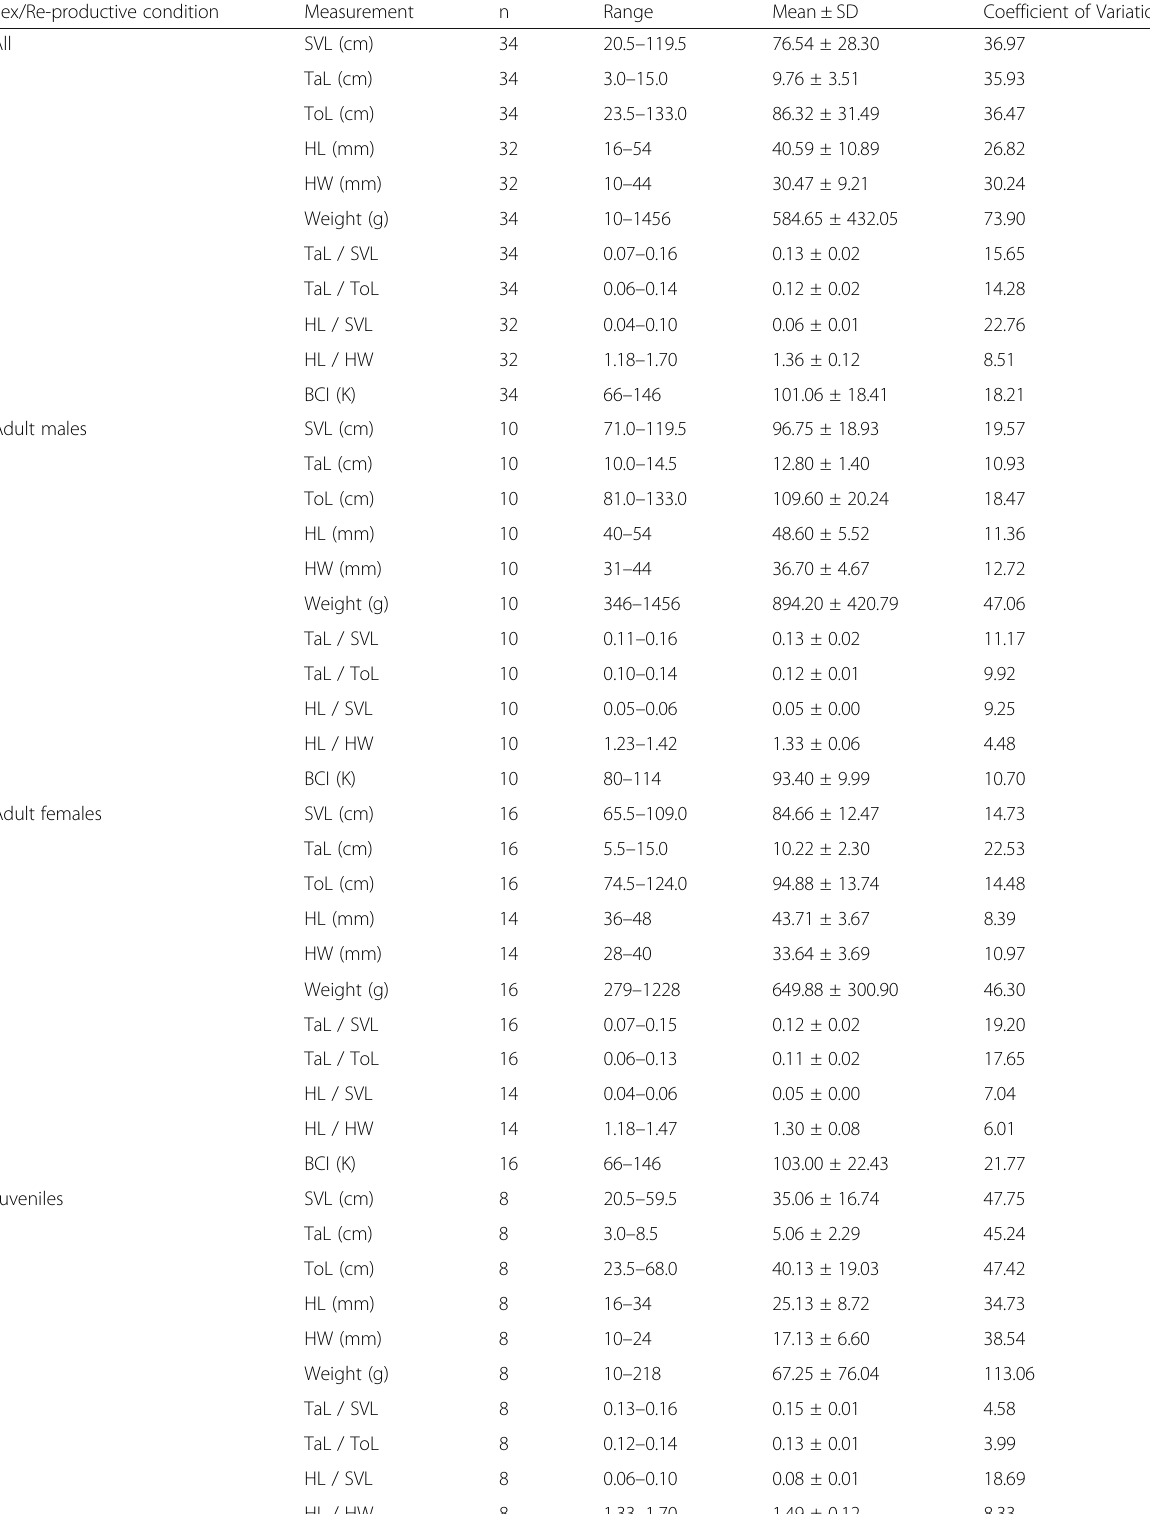
Table 1 Morphometric characteristics of juvenile and adult blunt-nosed vipers from Cyprus (SVL, TaL and ToL rounded to the nearest 0.5